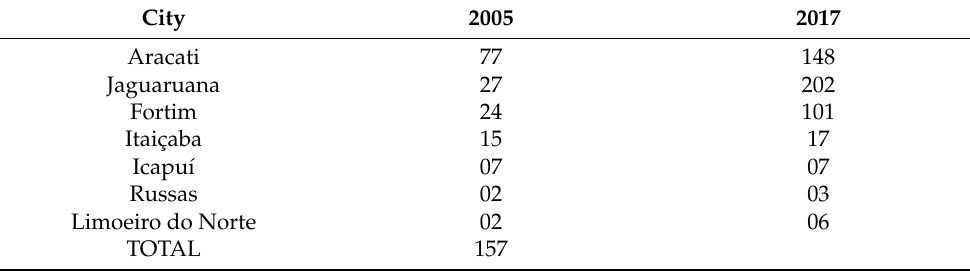
Table 2. Number of shrimp farming developments by the city in the LJRSB.